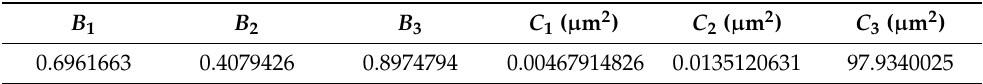
Table 1. The parameters in the Sellmeier